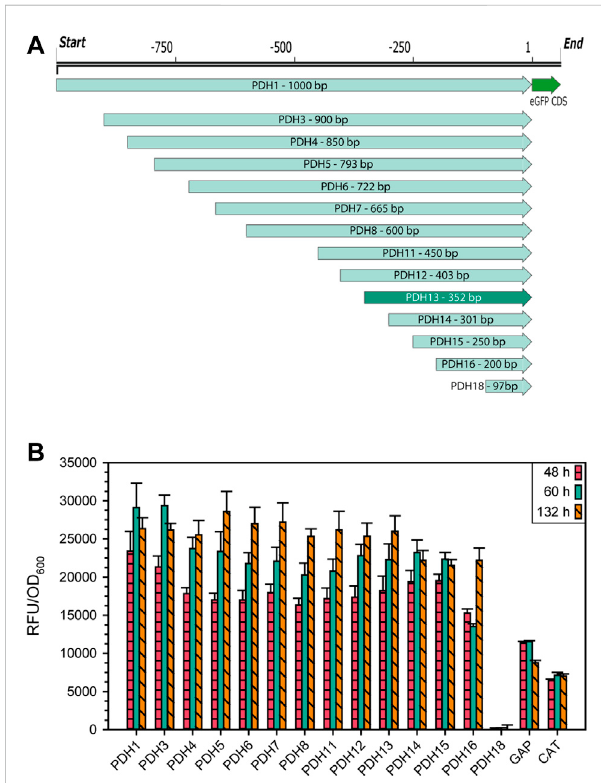
FIGURE 2 (A) Schematicrepresentationof14PDHpromotertruncationsfor identi fi cation of the essential promoter region with the reporter protein eGFP. (B) Expression levels of the different PDH promoter truncations in raw fl uorescence units normalized by cell density. Cells were cultivated in biological 7-fold replicates which represent the standard deviation, taking samples after 48, 60, and 132 h of cultivating with glycerol as sole carbon source. As controls, the same construct was used with P GAP and P DC instead of P DH